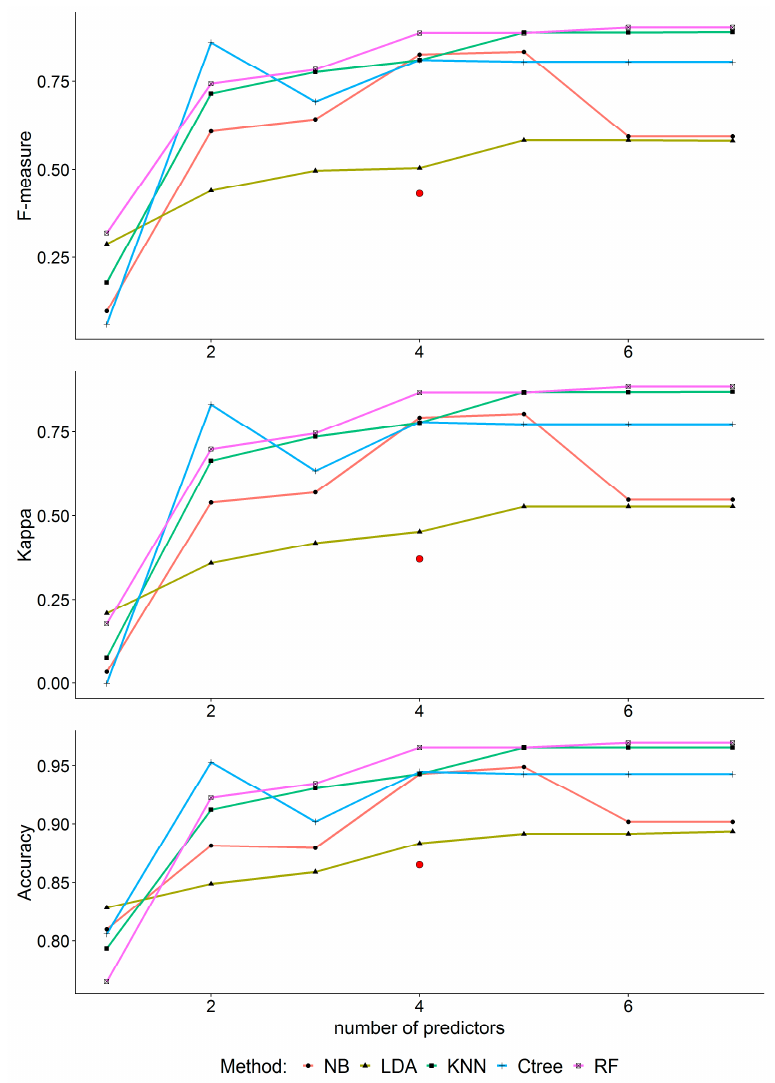
Figure 8. Performance of the machine ‐ learning classification methods with different numbers of features. Each model was trained on the Fürstenzell dataset and tested on the Regensburg dataset. The red point represents the performance of the Bu_15 method with four parameters.